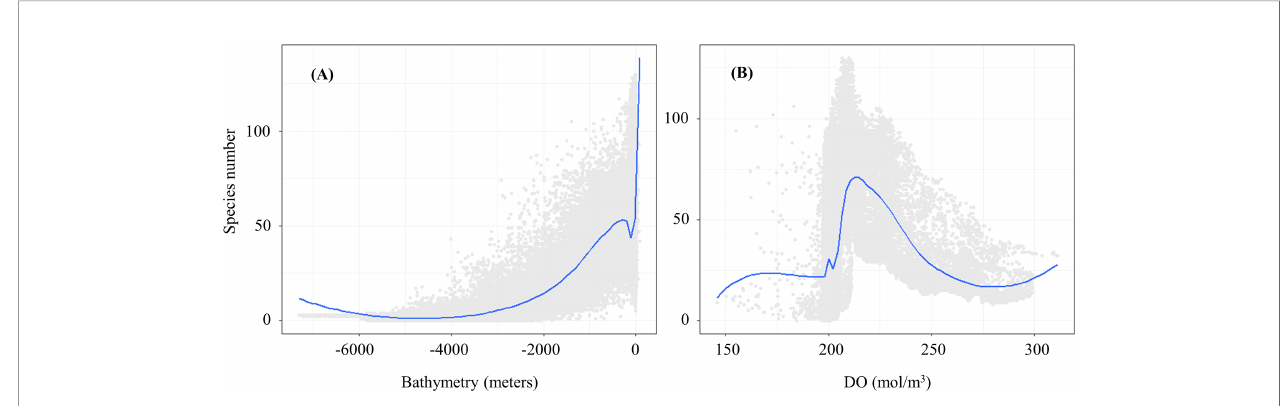
FIGURE 2 | Response curves among species number and the key environmental drivers (A. Bathymetry; B. DO).